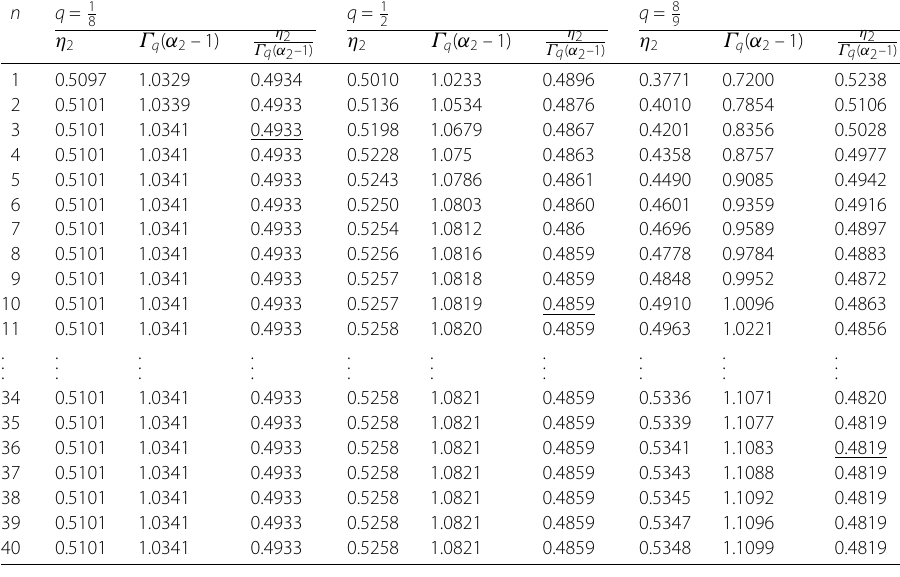
Table 5 Some numerical results of η 2 and Γ q ( α 2 – 1) from (17) in Example 1 for q ∈ { 1 can heck